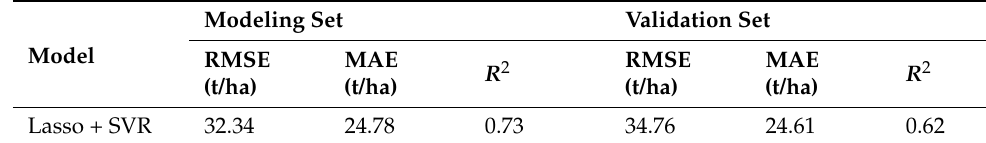
Table 6. Forest aboveground biomass Lasso-SVR model accuracy validation. Model